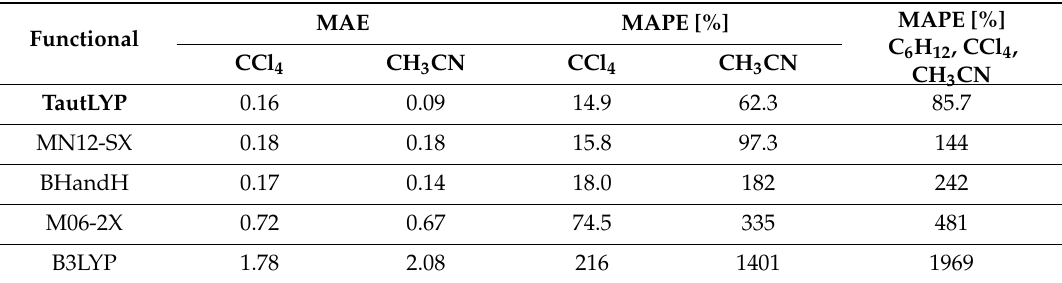
Table 5. Performance of the studied DFT functionals in respect of the data from Table